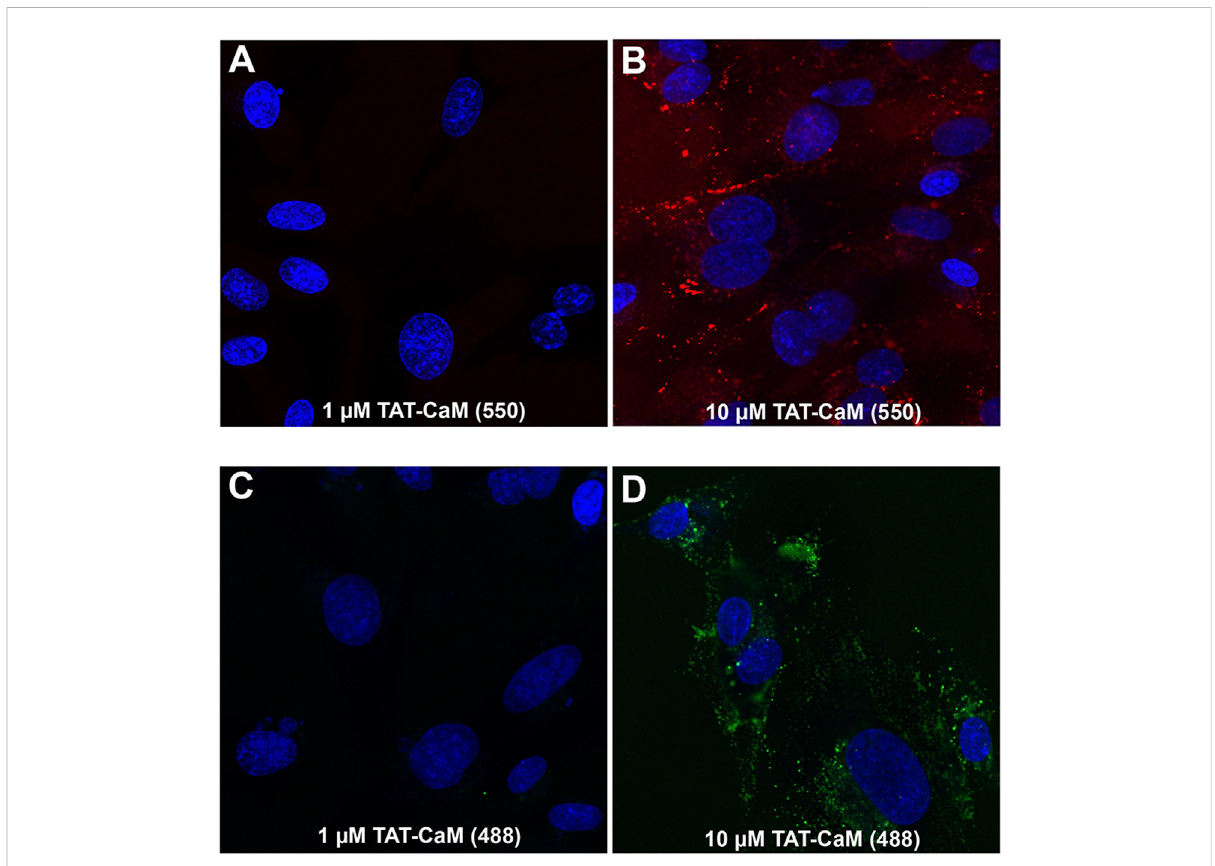
FIGURE 1 By itself, TAT-CaM internalization requires concentrations above 1 µM. BHK cells were incubated with (A,B) Dylight 550 or (C,D) Dylight 448 labeled TAT-CaM, respectively, for 60 or 30 min at 1 µM or 10 μ M, in DMEM with 10% FBS under a 5% CO2 atmosphere at 37 ° C. Cells were then washed 3 times with PBS (with Mg 2+ and Ca 2+ ) and imaged in media without phenol red but containing NucBlue. Dye incorporation averaged less than 0.3 dyes per TAT-CaM